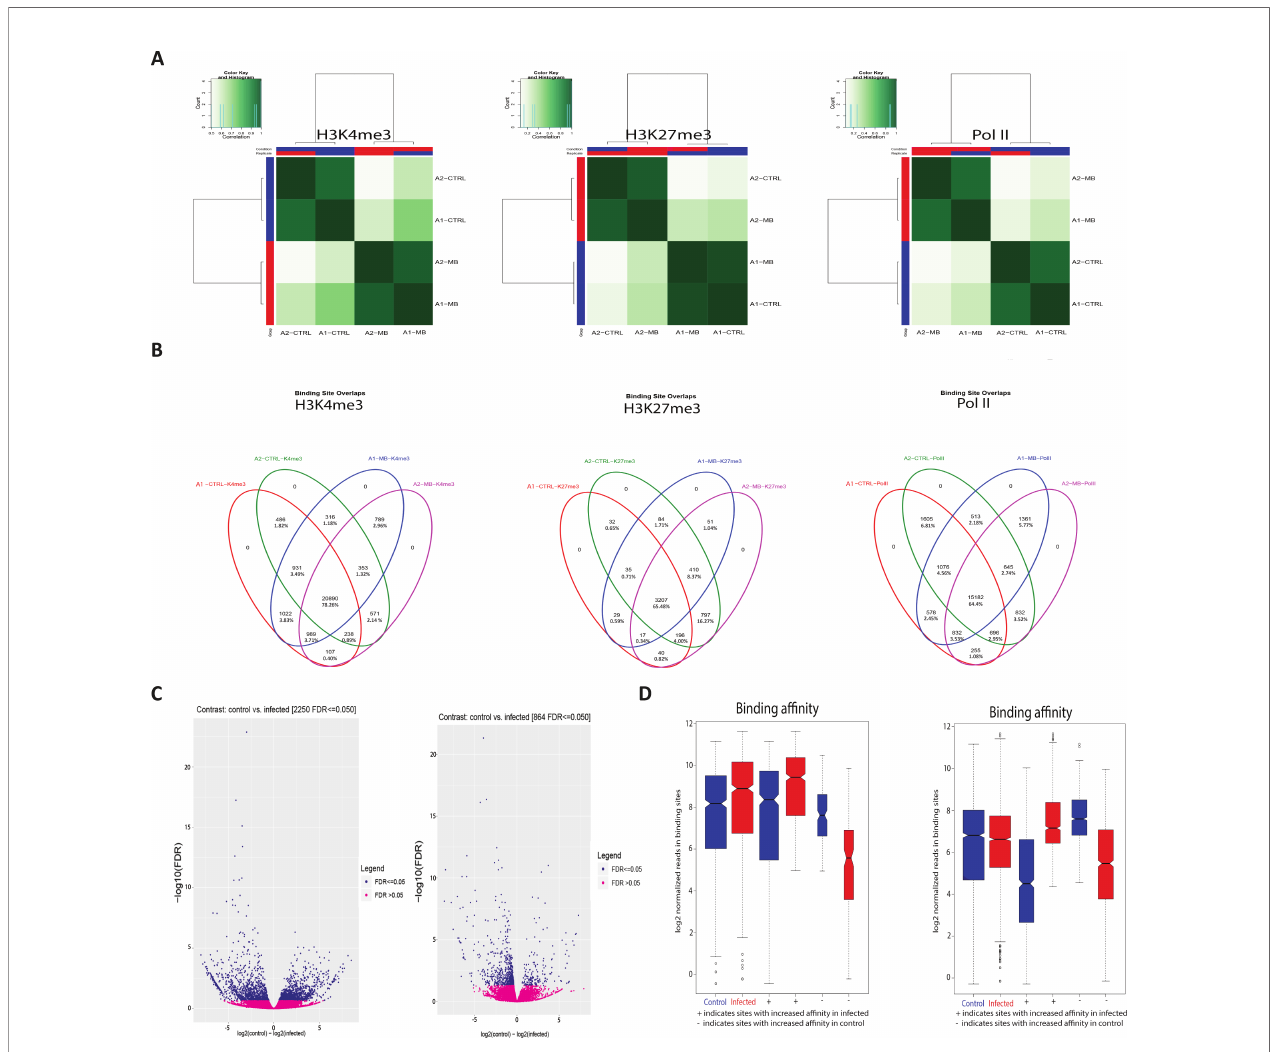
FIGURE 2 | M. bovis induced histone modi fi cations occur genome wide at key immune loci. (A) Correlation heatmaps of differential peaks for H3K4me3, H3K27me3 and Pol II. Every peak location that is not consistent between each animal in each condition (i.e. a peak only occurs in the control group) is compared to determine if these inconsistent peaks are correlated with the animal or the condition. The differential peaks in H3K4me3 and Pol II correlate highly with condition, whereas there were no signi fi cant global differences in the distribution of H3K27me3. (B) Venn diagrams of differential peaks for H3K4me3, H3K27me3 and Pol II. Each condition shares most peaks. Where differences occur at TSS of genes, these genes are frequently associated with immune function. (C) Volcano plots of differential peaks for H3K4me3 and Pol II. The y-axis shows signi fi cance as FDR and the x-axis indicates increase in af fi nity for control (left) and infected (right). Signi fi cant sites are denoted in blue. (D) Boxplots of differential peaks for H3K4me3 and Pol II. Infected bAM are shown in red and control bAM are shown in blue. The left two boxes of each plot show distribution of reads over all differentially bound sites in the infected and control groups. The middle two boxes of each plot show the distribution of reads in differentially bound sites that increase in af fi nity in the control group. The far-right boxes in each plot show the distribution of reads in differentially bound sites that increase in af fi nity in the infected